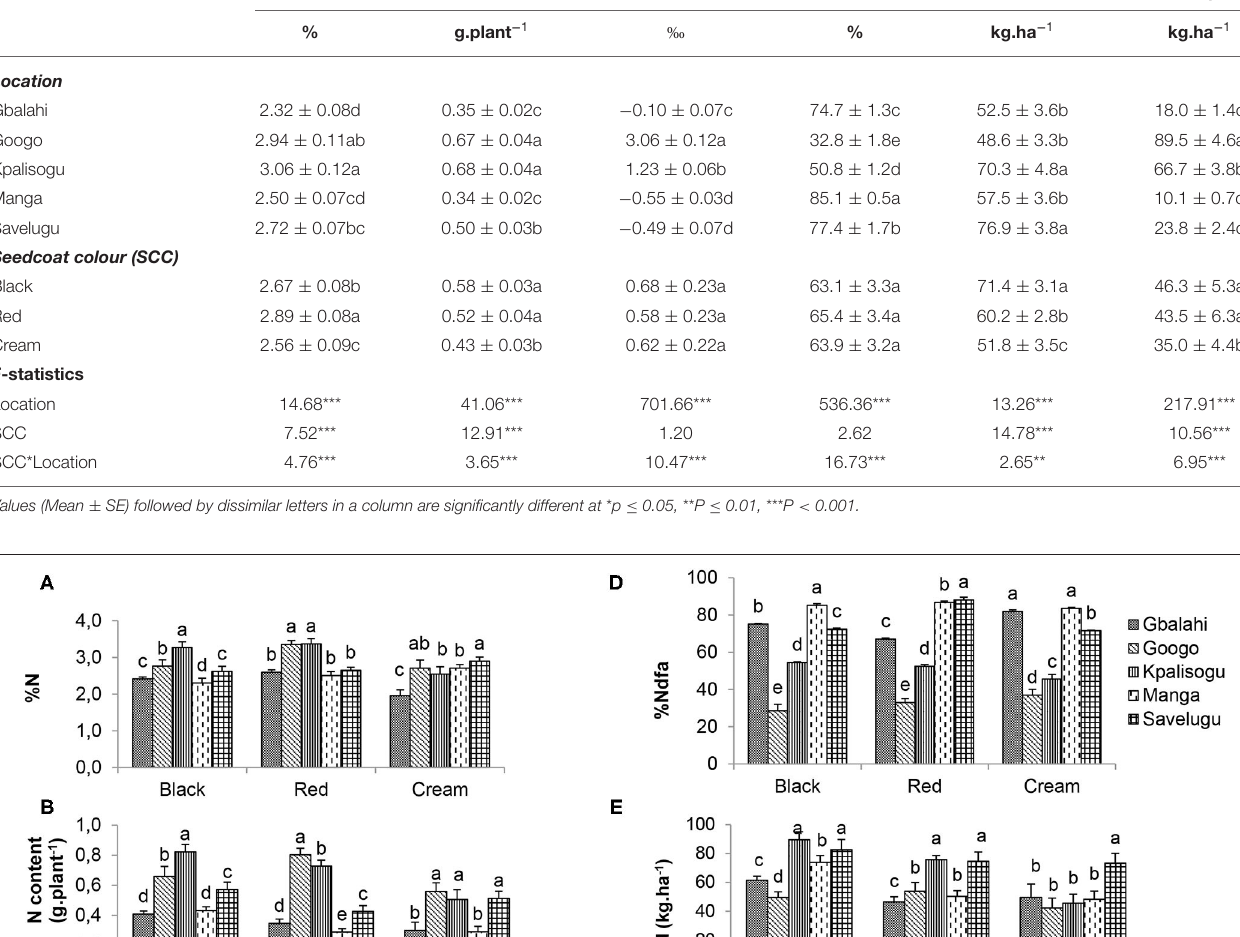
The Red landrace similarly exhibited higher amounts of N- fixed at Kpalisogu and Savelugu, and the lowest at Gbalahi. In contrast, the amount of N-fixed by the Cream landrace was much greater at Savelugu than the other four sites, which showed